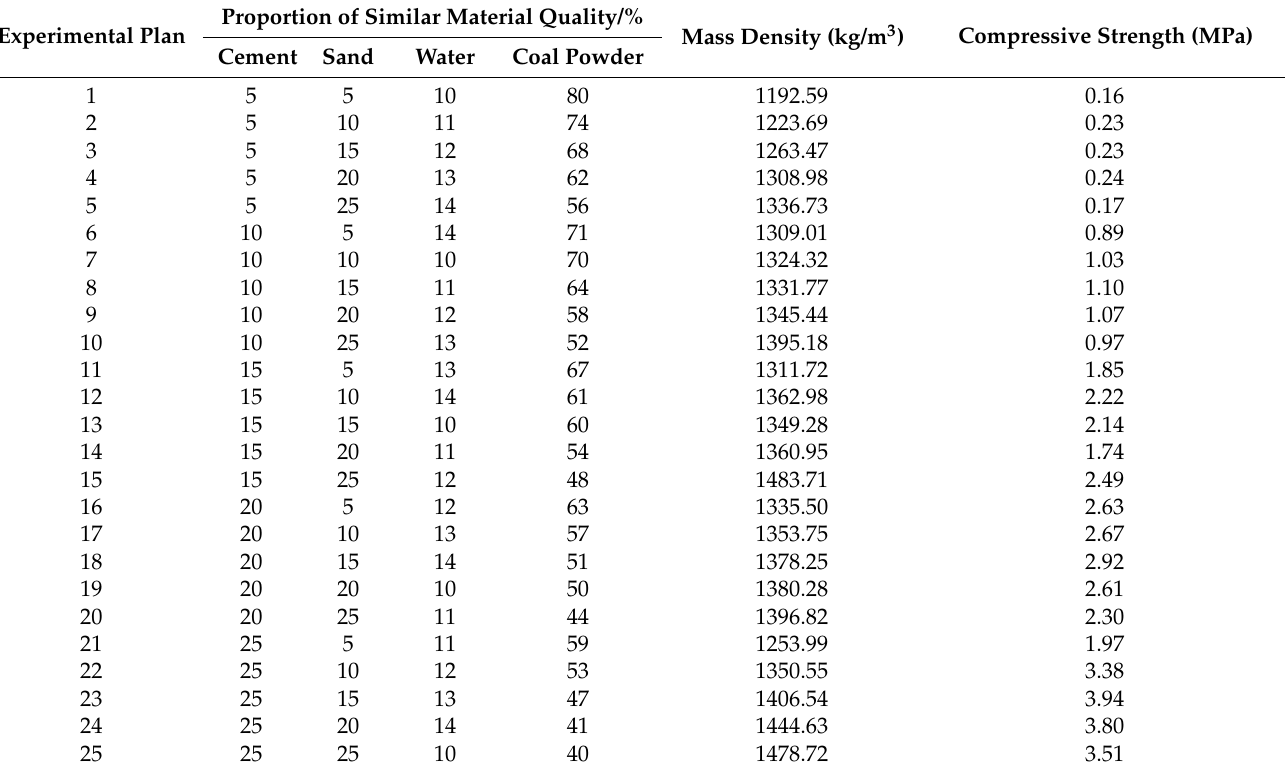
Figure 6. Stress-strain curve of simulated coal sample. Table 4. Orthogonal test results of simulated coal samples.